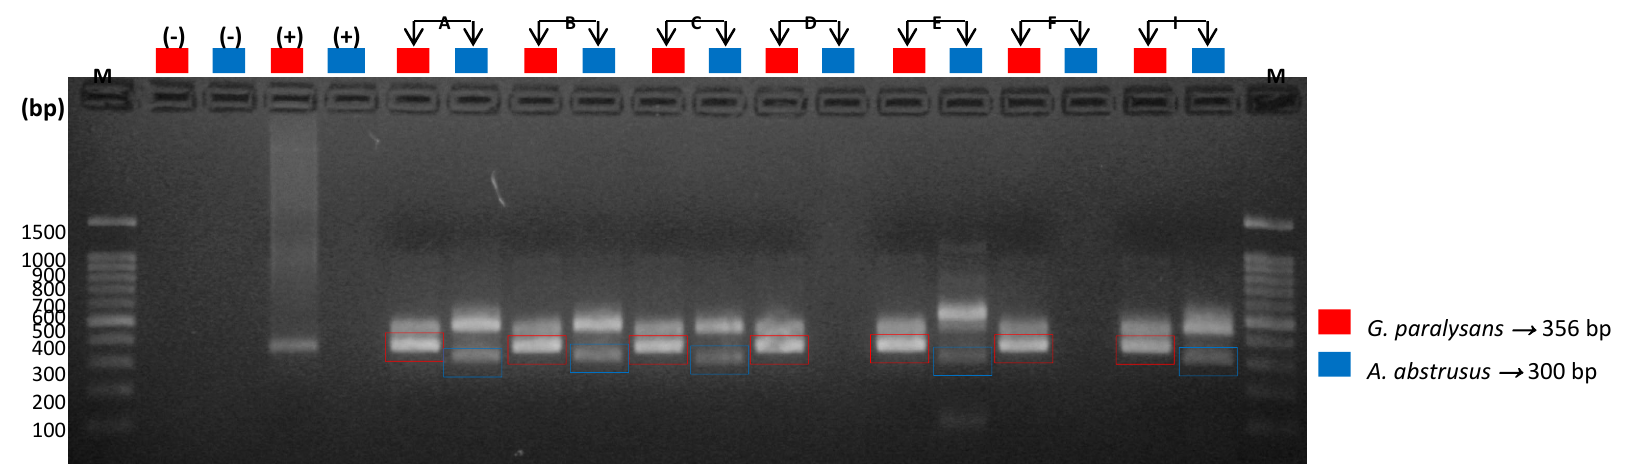
Figure 5. Molecular detection of G. paralysans and A. abstrusus by semi-nested PCR in serum samples from domestic cats. M: Molecular weight marker; ( − ): Negative Control; ( + ): Positive Control; bp: base pairs; A, B, C, D, E, F and I: domestic cats analysed in this